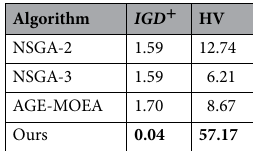
Table 4. Comparison of optimization algorithms. Significant values are in [bold].